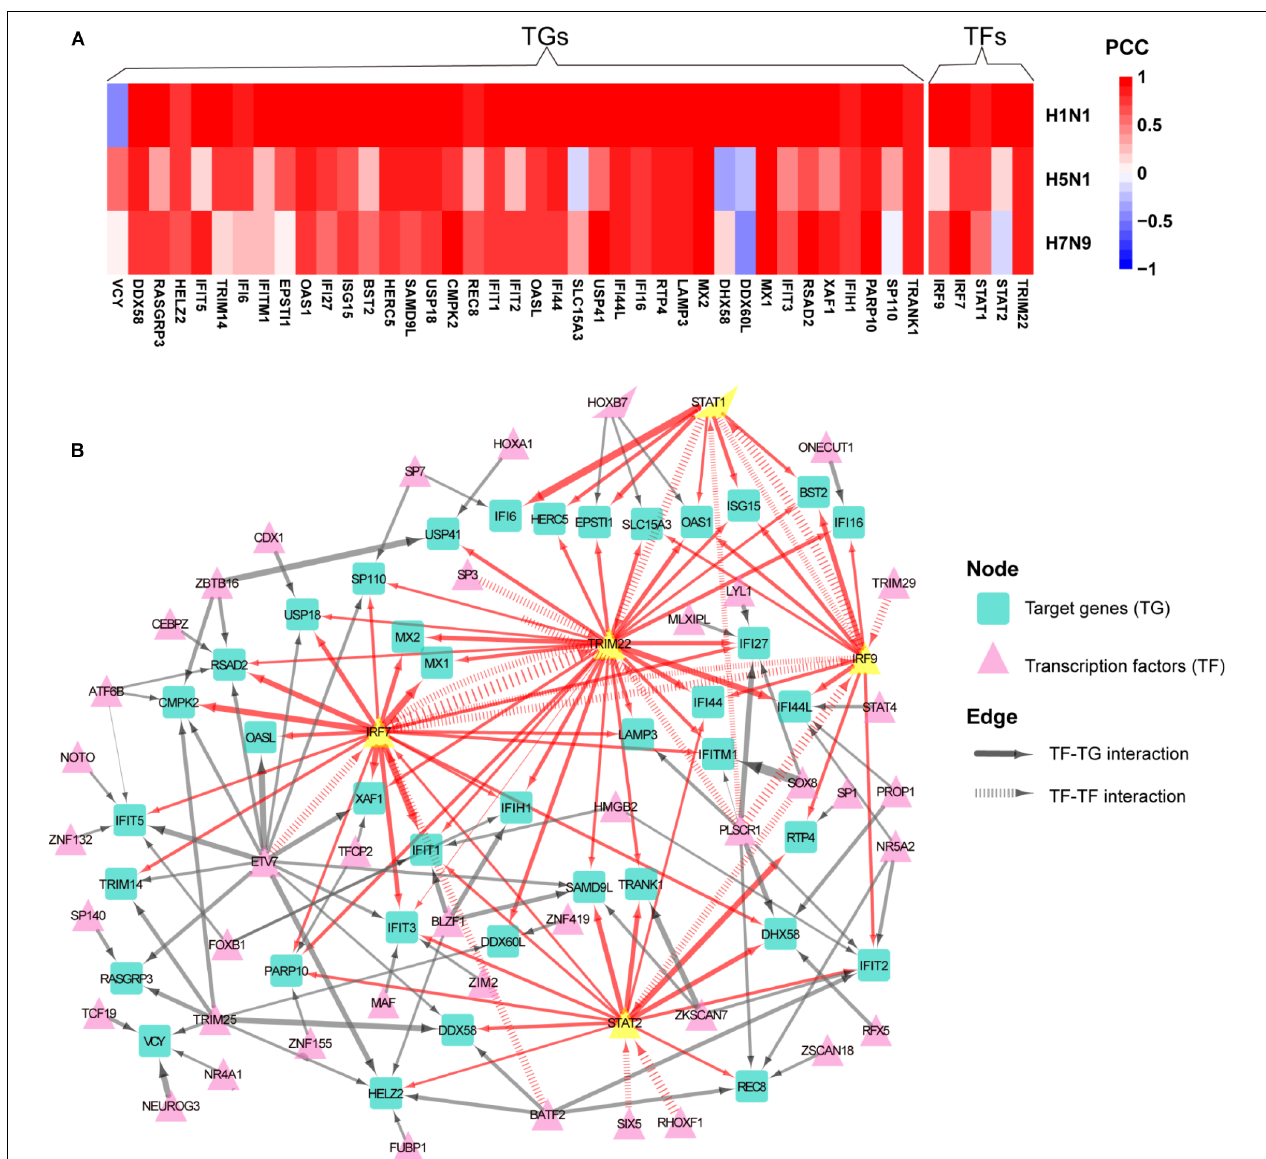
FIGURE 4 | Aberrant regulation patterns of the 44 early upregulated ASGs upon infection of avian IAV. (A) Comparison of regulation patterns of the 44 ASGs during infection of human and avian IAV. High PCCs between true and predicted gene expression levels represent high prediction accuracies, which indicates that normal regulation patterns induced by interferon are kept by IAV, while low PCCs for disturbed regulation patterns. (B) Regulatory network of the 44 ASGs. For the 44 ASGs, their potential upstream regulators are given by the corresponding LASSO models with coefficients at least 0.1. The wider edges represent larger coefficients. The red edges are related to five key TFs with yellow